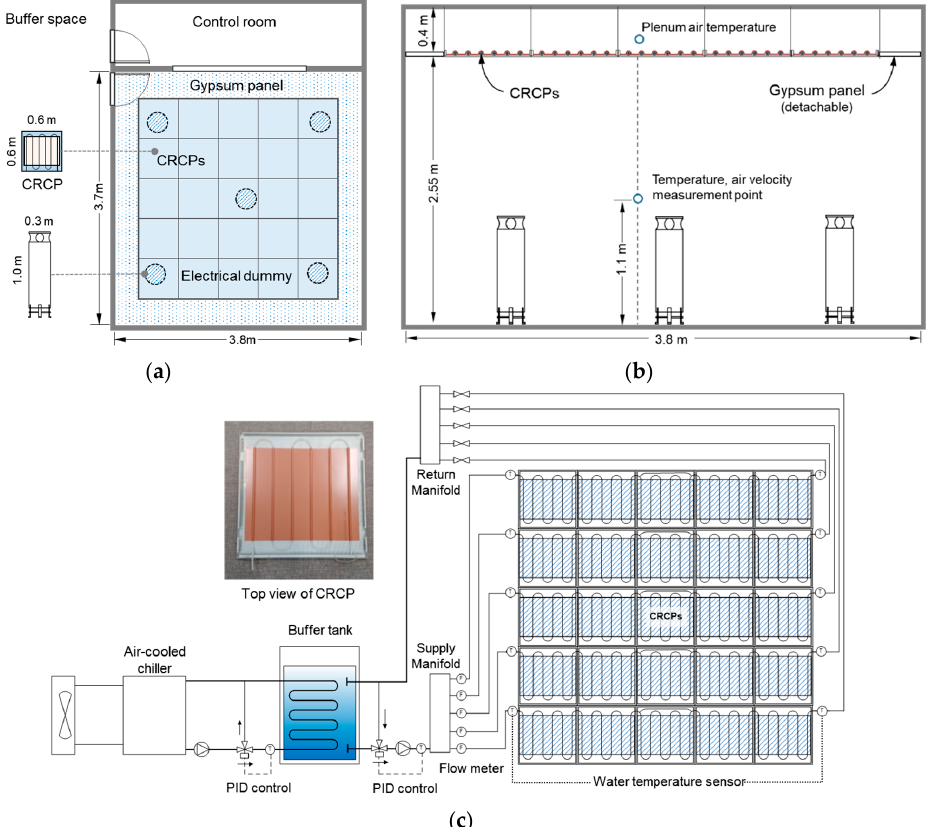
Figure 1. Configuration of the mock-up test chamber for the evaluation of ceiling radiant cooling panel (CRCP) performance: ( a ) floor/ceiling plan view; ( b ) sectional view; ( c ) mechanical system.